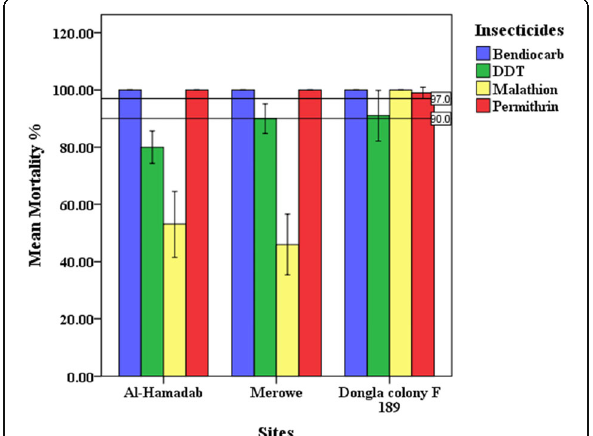
Fig. 3 Mean mortality rates of Anopheles arabiensis exposure to insecticides. Mean mortality according to site type (urban and rural). Bars show mean mortality with standard deviation (SD). Solid horizontal lines show the WHO mortality threshold for the definition of resistant